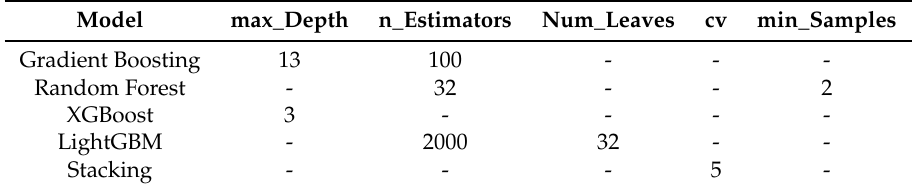
Table 2. The model parameters of